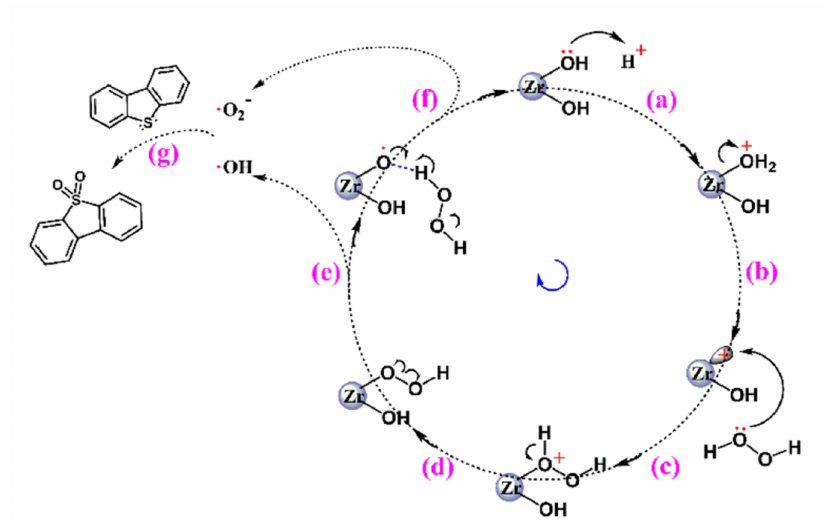
Scheme 8. Proposed mechanism of DBT oxidation with H 2 O 2 over Zr-MOFs. For ( a – g ) see the